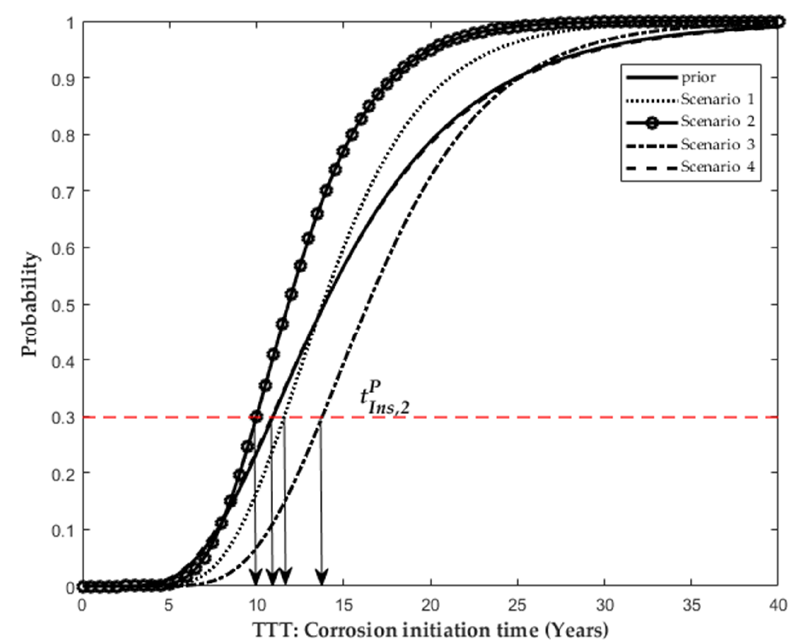
( t ) based on inspection